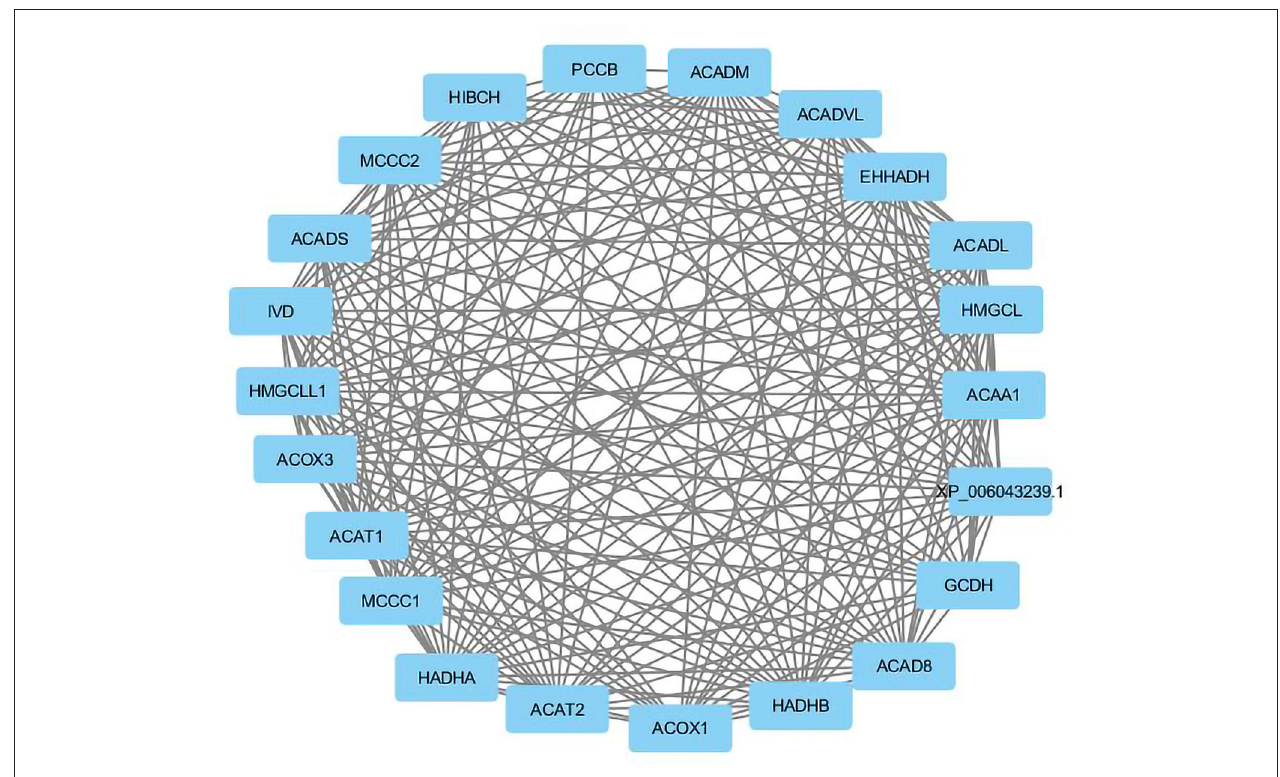
FIGURE 5 | The cluster of proteins highly connected in protein-protein interaction